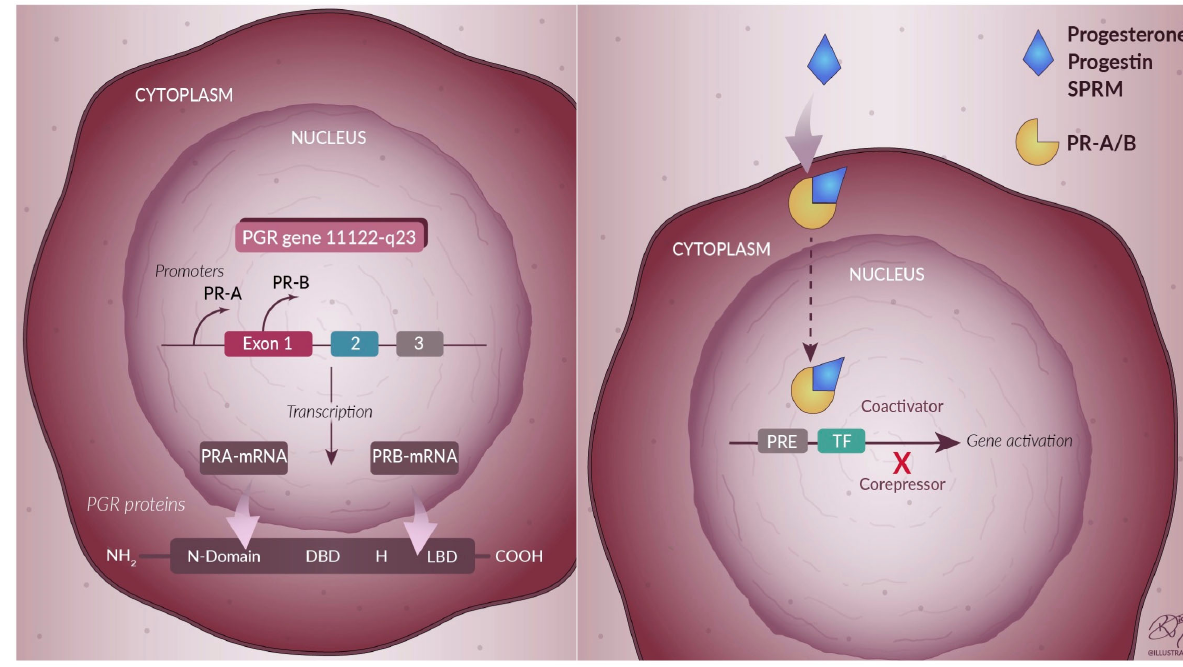
Figure 2. Progesterone receptors and their activation. The nuclear receptor is formed by two promoter regions on the PR gene, one for PRA and one for PRB, and these two promoters allow the synthesis of the two separate mRNA transcripts that code for the two different isoforms PRA and PRB. DBD = DNA-binding domain, H = hinge, LBD = ligand-binding domain, SPRM = selective progesterone receptor modulator, PRE = progesterone responsive element, TF = transcription factor.